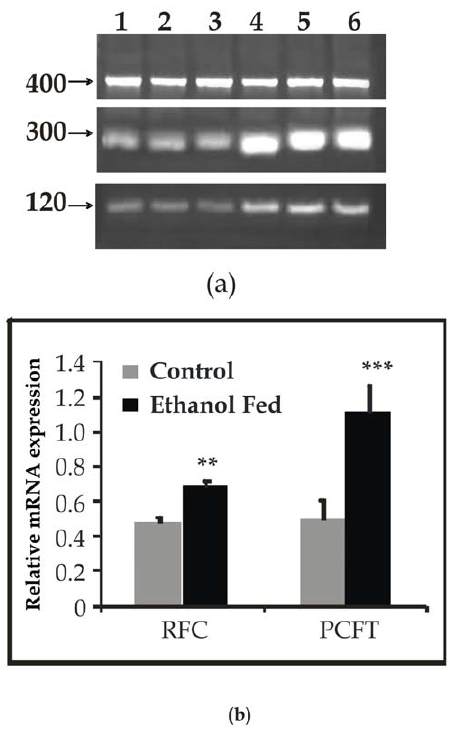
Figure 4. RT-PCR analysis of RFC (120 bp) and PCFT (300 bp) with GAPDH (400 bp) as an internal control in pancreas. (a) Resolved on 1.2% agarose gel electrophoresis and (b) densitometric analysis representing relative change in PCFT and RFC mRNA expression. Data shown are representative of 5 separate sets of experiments. Lanes 1-4: Control; 5–8: Ethanol fed. ** p , 0.01, *** p , 0.001 vs. Control.